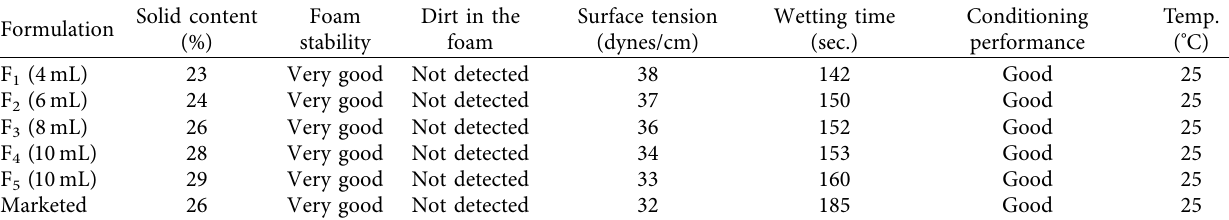
Table 6: Evaluations of A. elegans hair washing formulations.